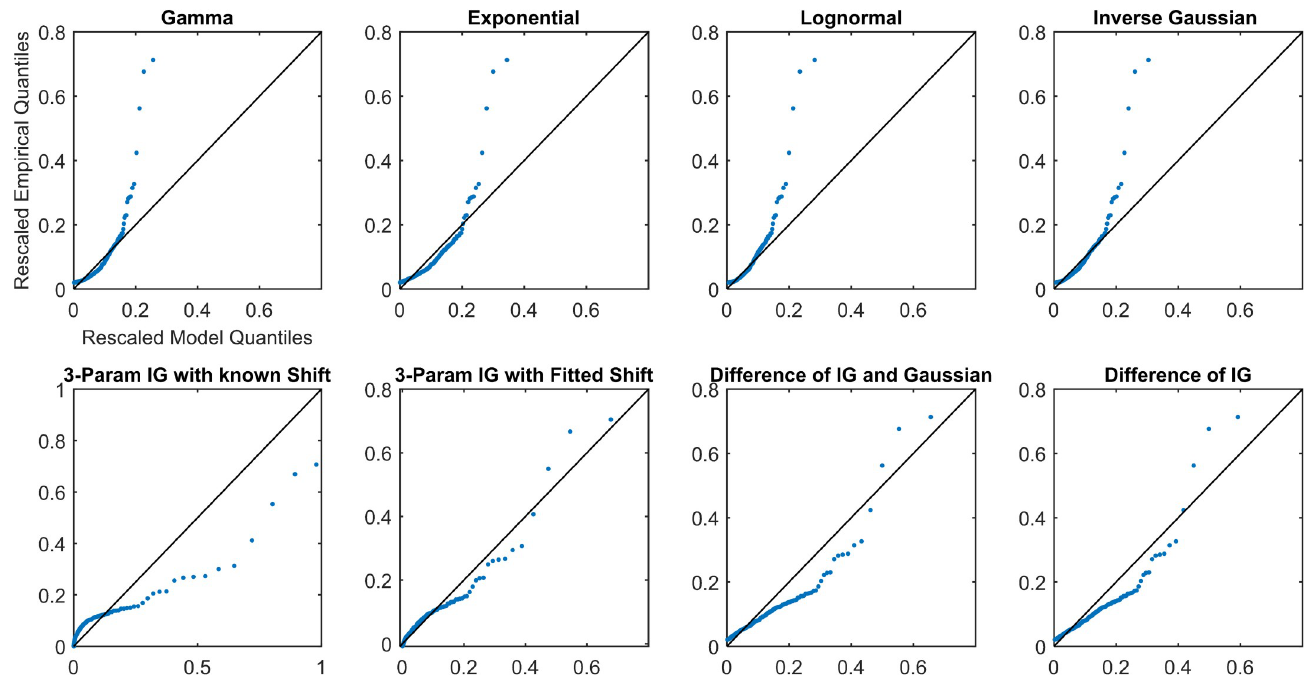
Fig 5. Rescaled QQ plots for Subject P10 from the propofol sedation cohort.